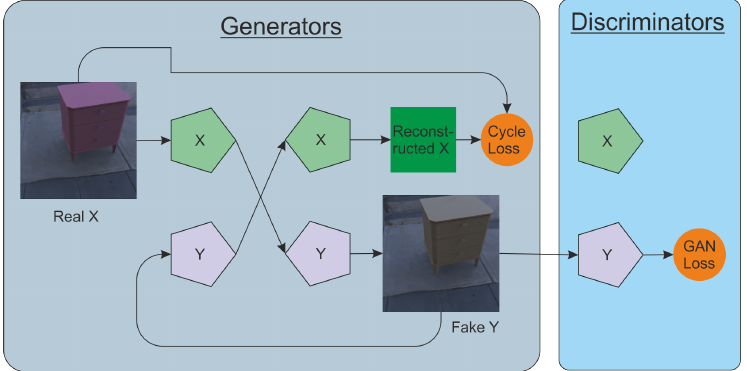
Figure 17. Scheme of CycleGAN modification used as the basic method of image